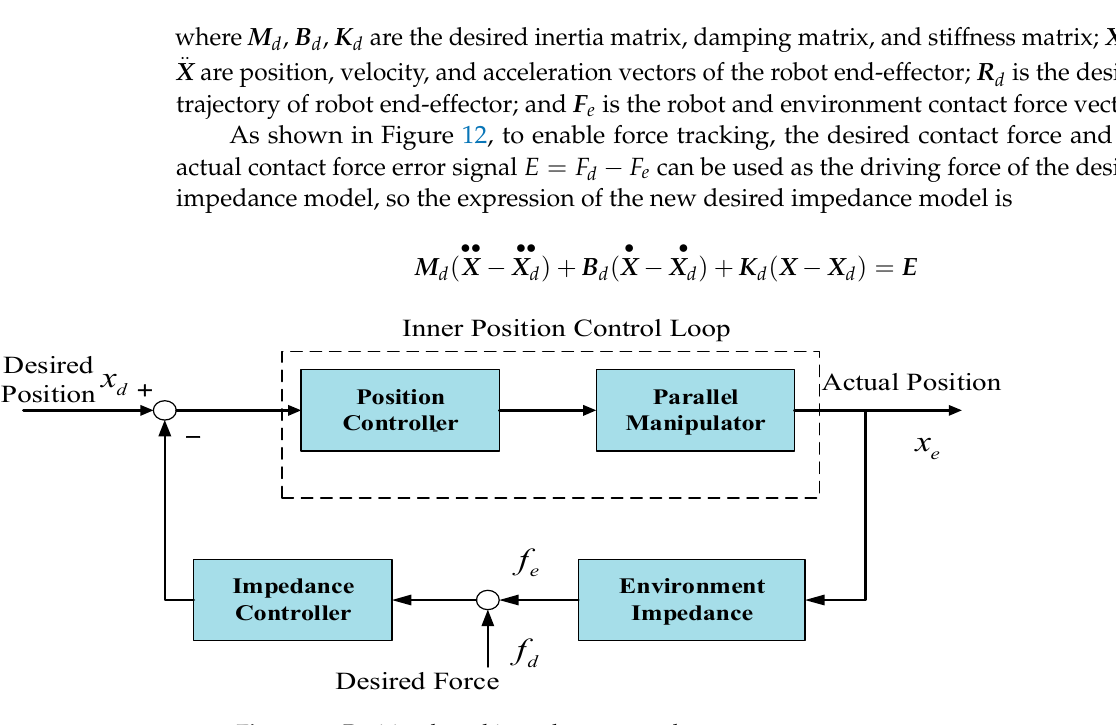
Figure 12. Position-based impedance control strategy.